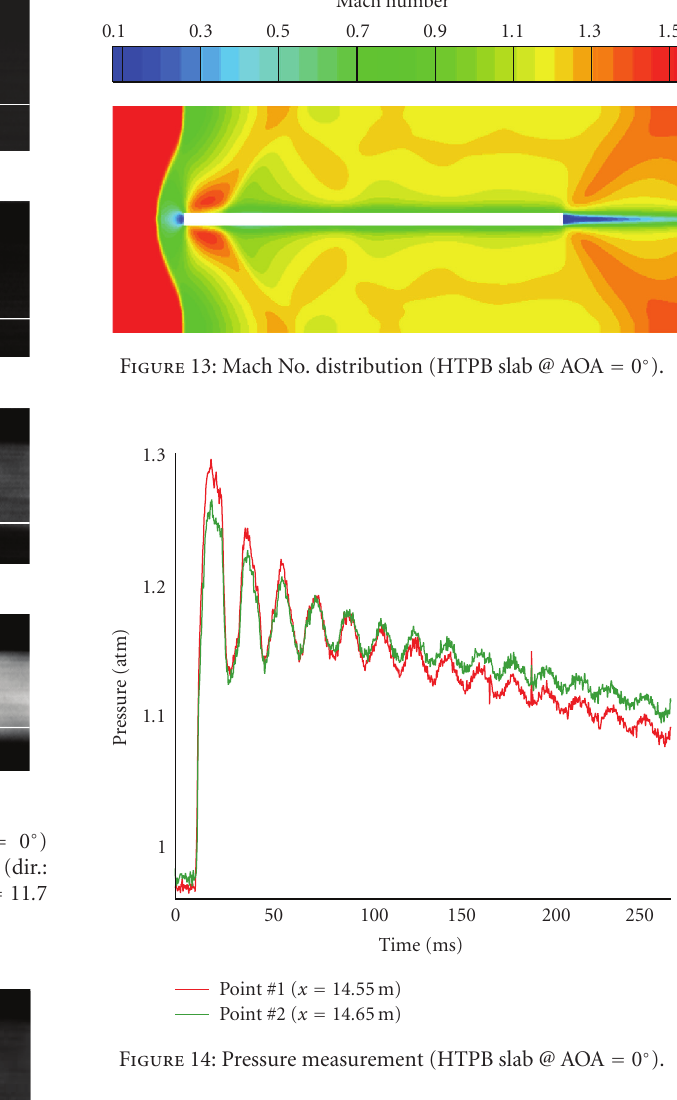
slab, AOA = 0 deg, at t = 11 . 1 milliseconds. The bow shock occurred because of the blunt shape configuration.